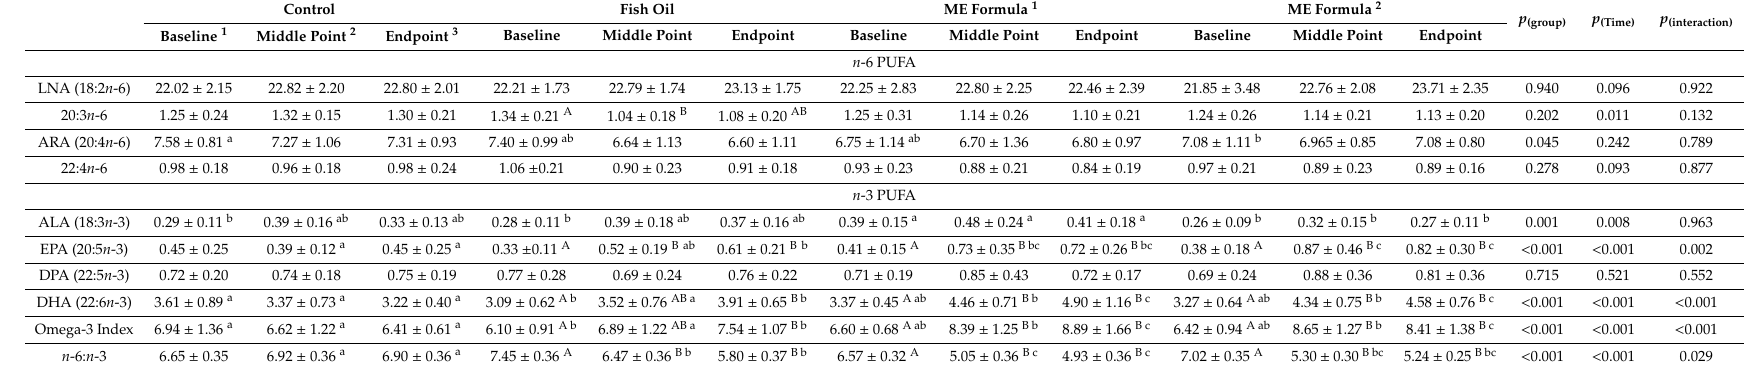
Table 4. Selected whole blood omega-3 fatty acids (%) and Omega-3 Index in toddlers fed di ff erent